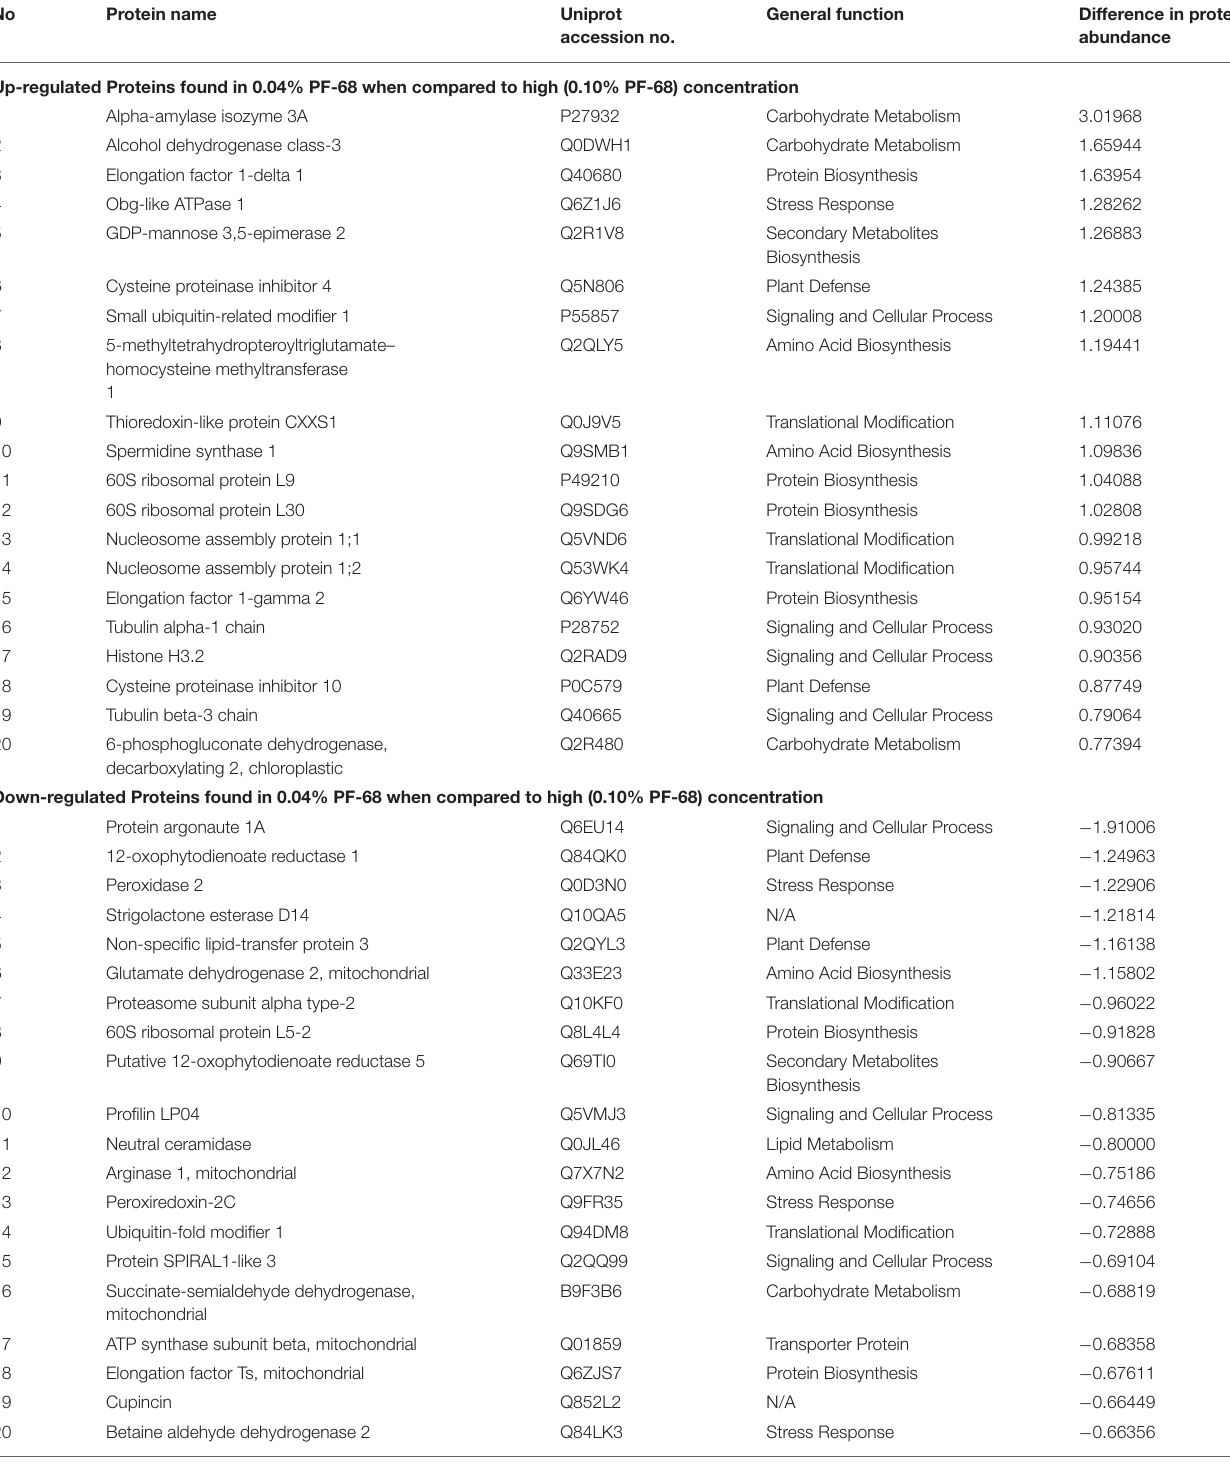
TABLE 4 | Top 20 proteins showing significant abundance difference (together with their accession numbers) when compared between optimum and high PF-68 concentrations. No Protein name Uniprot